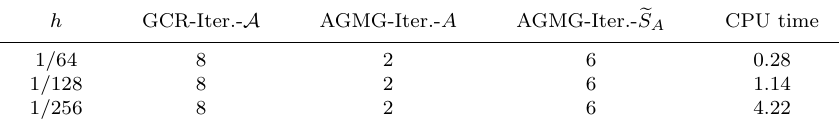
Table 3. Number of iterations for computing ( v n +1 ,p n +1 ) in Algorithm 2. h GCR-Iter.-